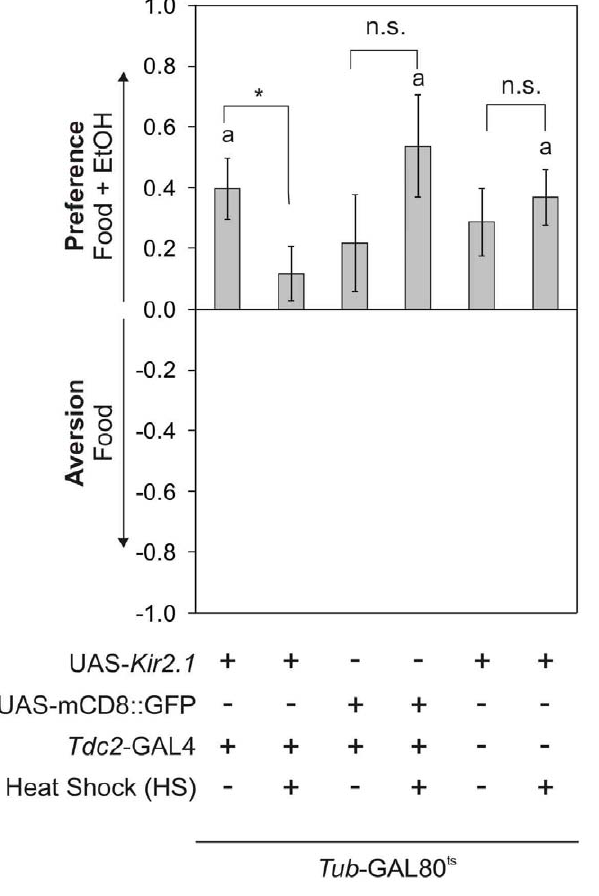
Figure 5. Neuronal activity is required for preference. After activation of UAS-Kir2.1 under the control of Tdc2 -GAL4, tub -GAL80 ts preference is significantly reduced (PIs are Tdc2 -GAL4, tub -GAL80 ts ; UAS- Kir2.1 0.4 6 0.1 and with HS 0.12 6 0.09. n 22. P , 0.05). Activation of a UAS- mCD8::GFP construct does not interfere with preference (PIs are Tdc2 -GAL4, tub -GAL80 ts ; UAS -mCD8::GFP 0.22 6 0.16 and with